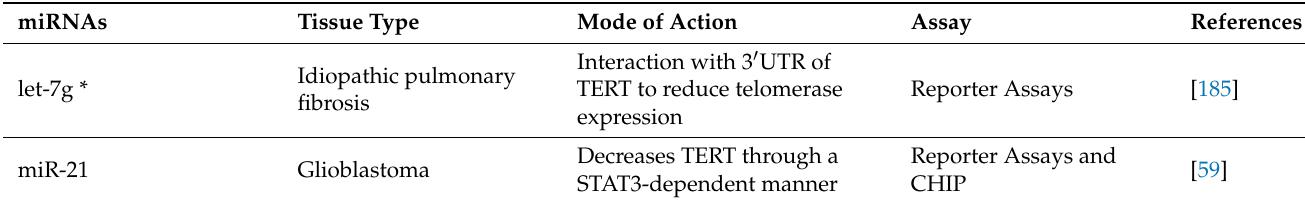
Table 3. Regulation of TERT through